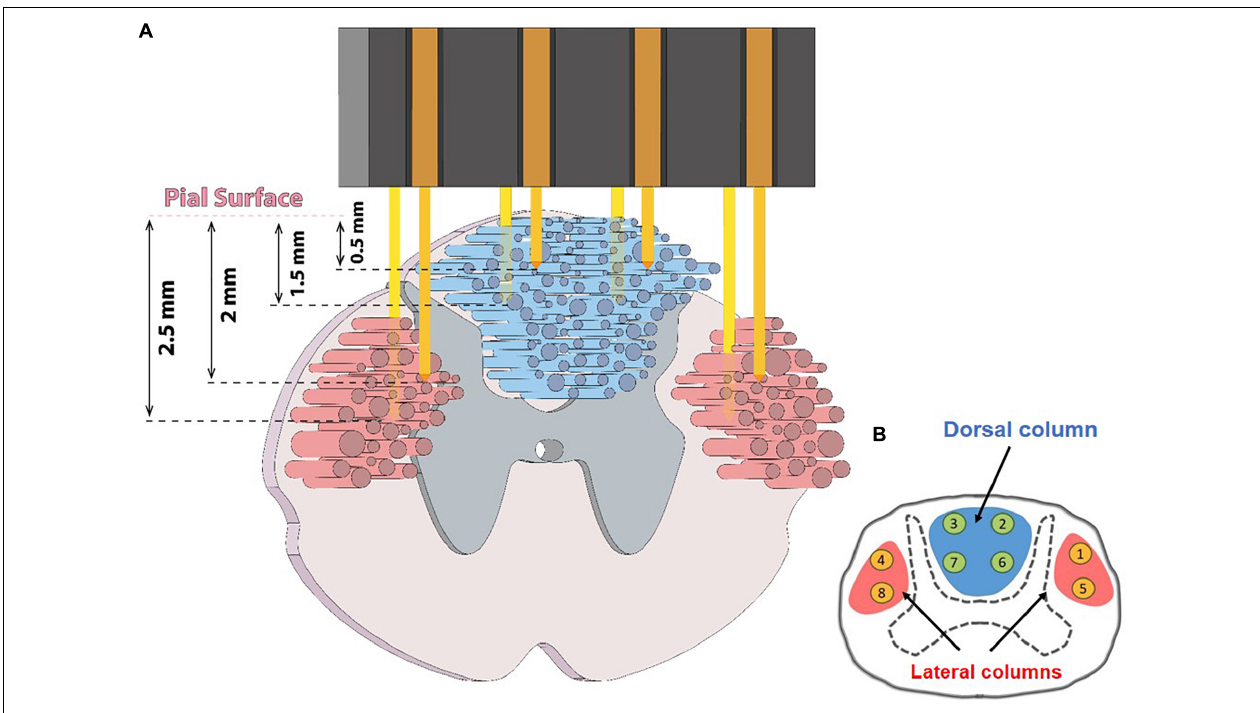
FIGURE 1 | (A) Schematic figure showing ascending and descending tracts in the spinal cord and how and where the microwire array was implanted. (B) Numbering of eight implanted electrodes in the dorsal and lateral columns.